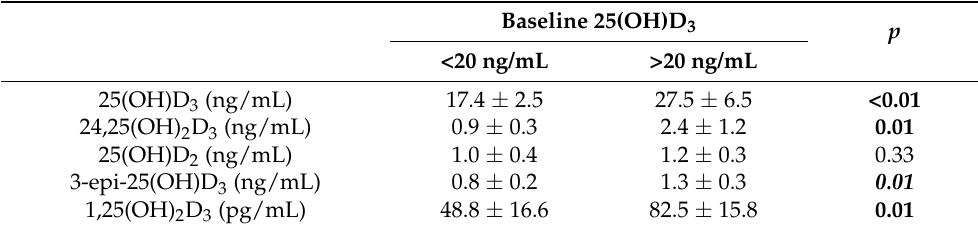
Table 3. Differences in vitamin D metabolite levels in subgroups with different baseline 25(OH)D 3